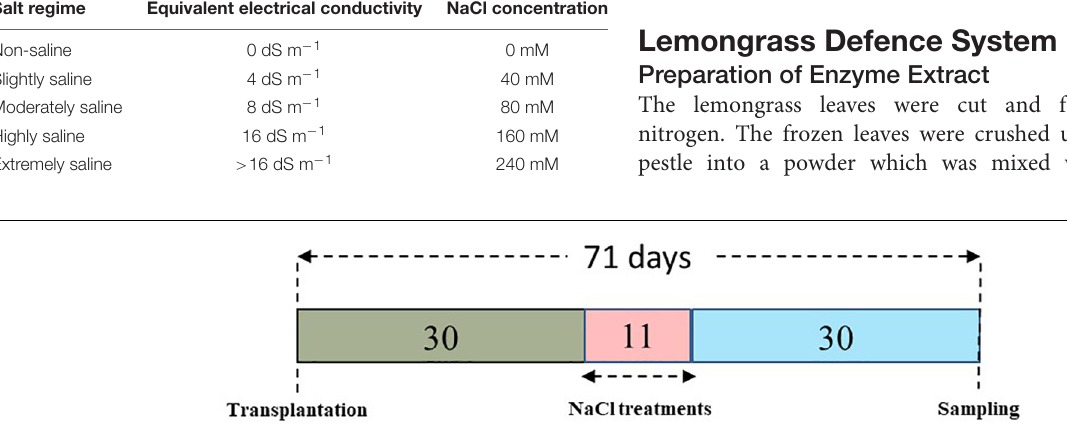
FIGURE 1 | The experimental timeline for the present